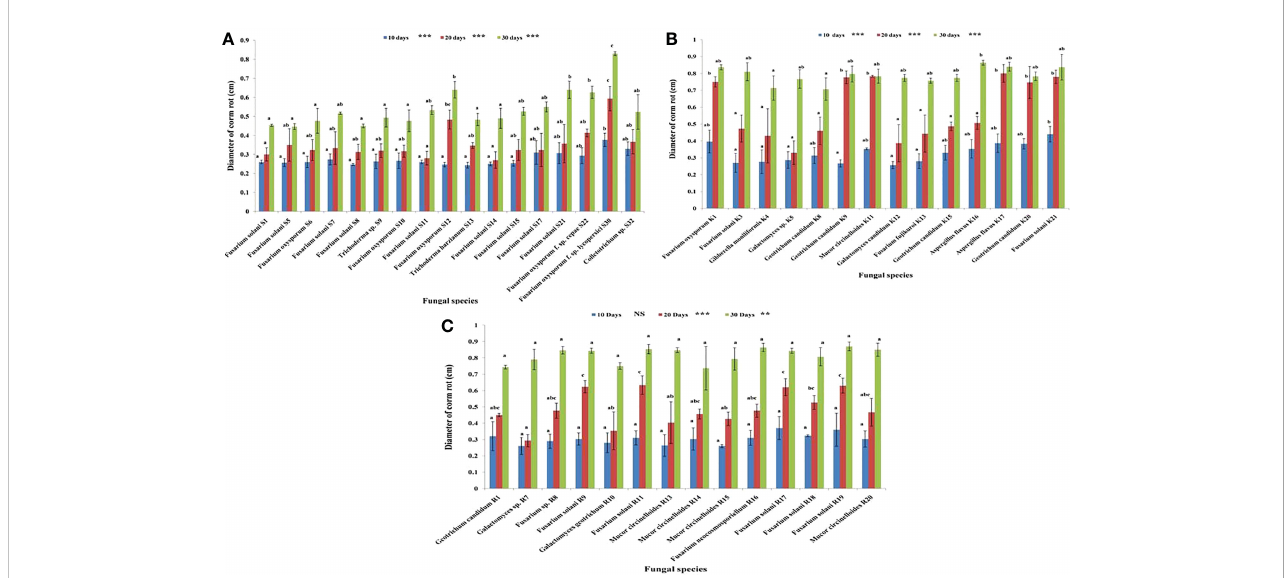
FIGURE 2 (A) Diameter of corm rot (in cm) caused by fungal species isolated from Srinagar soil at 10, 20, and 30 days post-inoculation. (B) Diameter of corm rot (in cm) caused by fungal species isolated from Kishtwar soil at 10, 20, and 30 days post-inoculation. (C) Diameter of corm rot (in cm) caused by fungal species isolated from Ramban soil at 10, 20, and 30 days post- inoculation. Mean diameters in the same day bar followed by lowercase letter(s) are signi fi cantly different at p ≤ 0.05, according to Tukey ’ s test. *, signi fi cance at p < 0.05; **, signi fi cance at p < 0.01; ***, signi fi cance at p < 0.001; NS, no signi fi cant